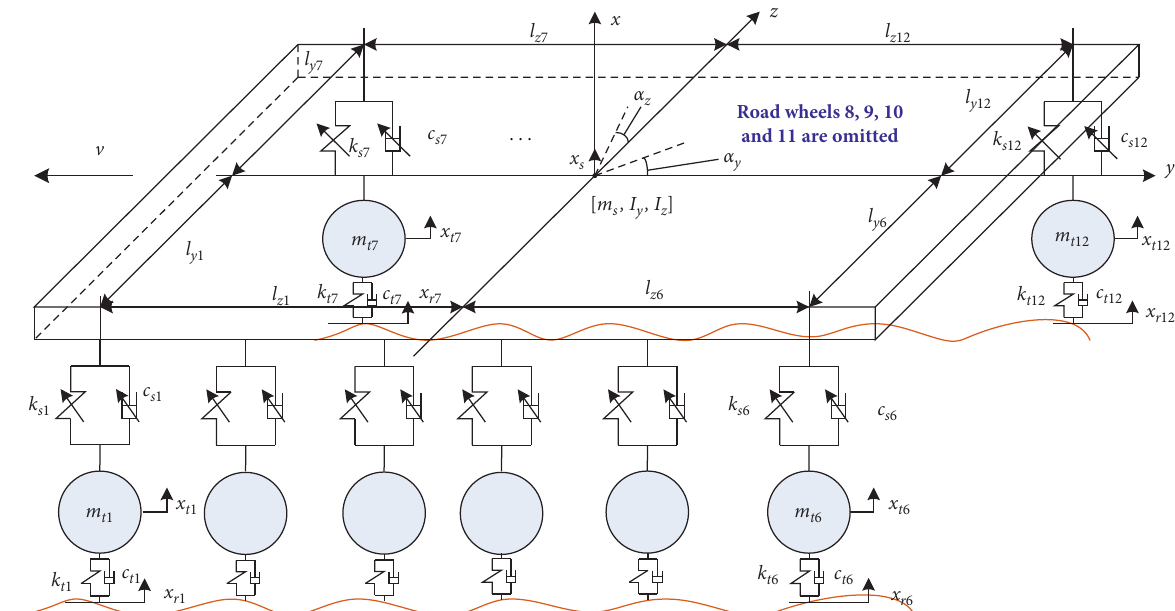
Figure 2: Dynamics analysis model of the tracked